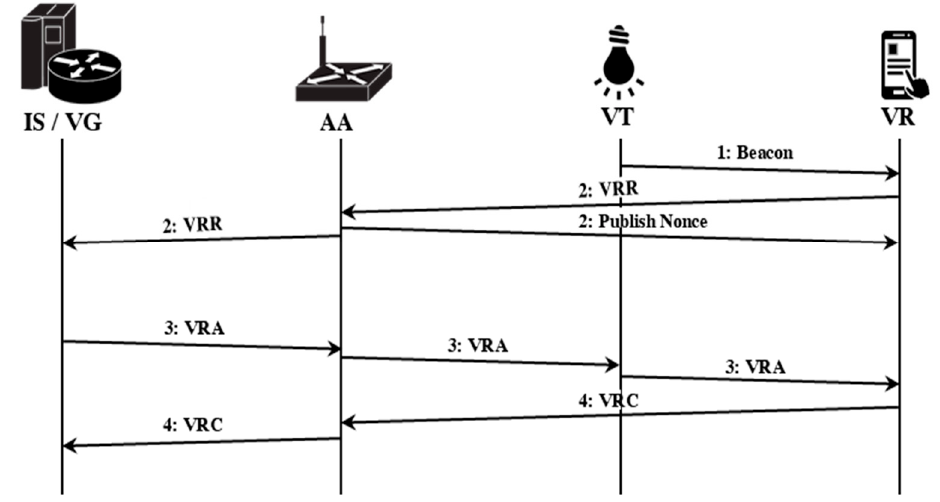
Figure 6. VR discovery operations.